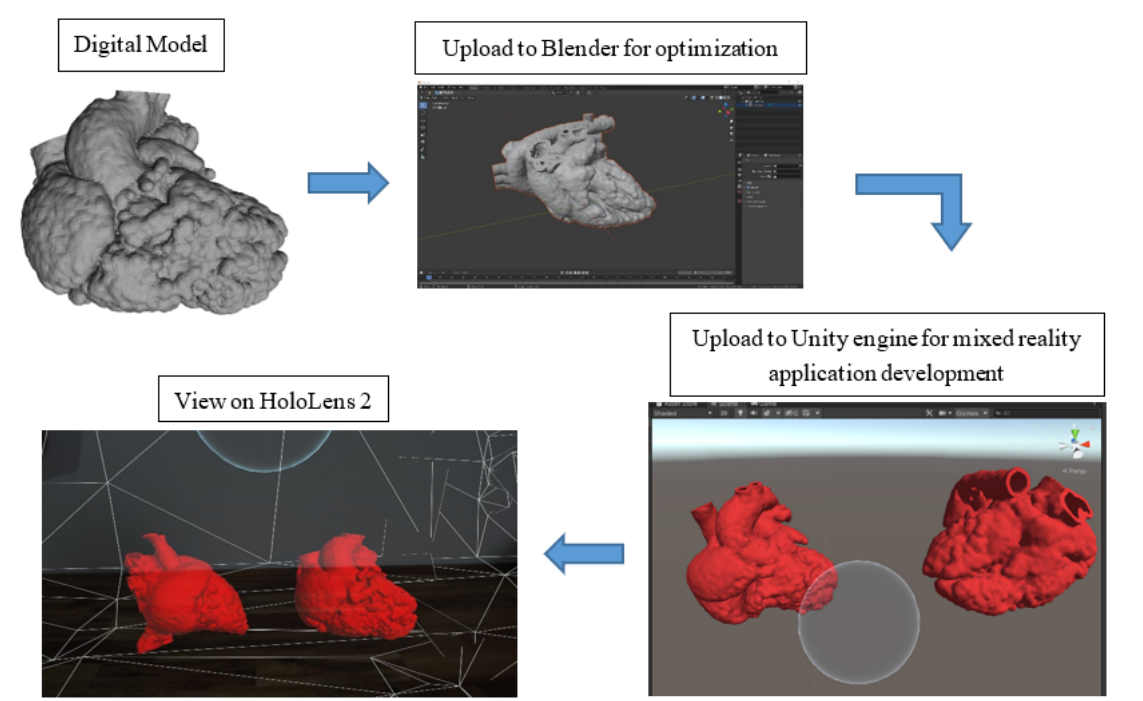
Figure 2. A flow diagram illustrating the process of mixed reality application development.